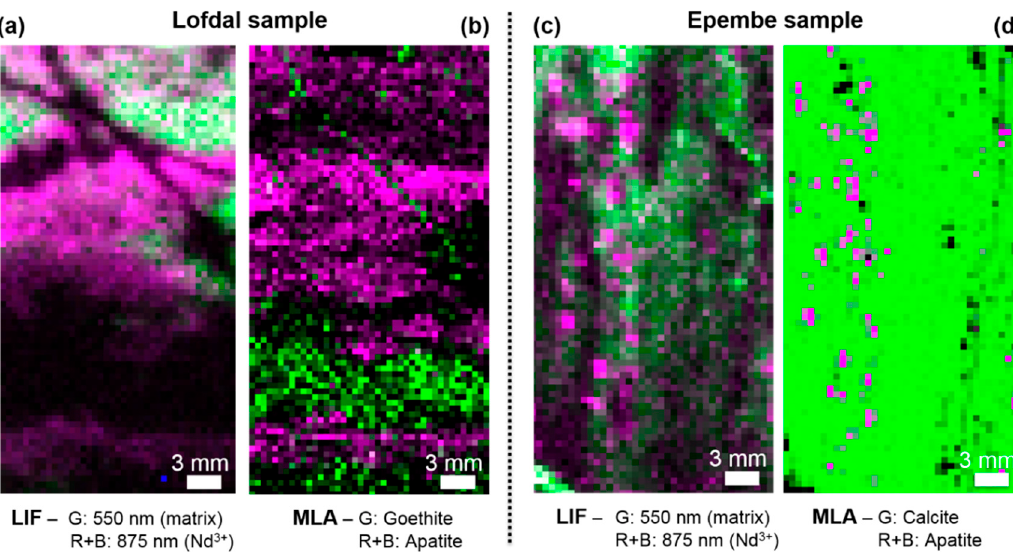
Figure 7. ( a ) 2D LIF map from the Lofdal sample after excitation with a 442 nm laser at a pixel distance of 0.5 mm. ( c ) 2D LIF map under the same conditions for the Epembe sample. ( b , d ) For comparison, the corresponding resampled mineral liberation analysis (MLA) maps are shown next to the LIF maps, the depicted mineral phases visualize the occurrence of the main minerals (calcite, goethite, and apatite). Magenta pixels represent the occurrence of REE emissions in the LIF images and the related occurrence of apatite as main mineral phase in the MLA maps.